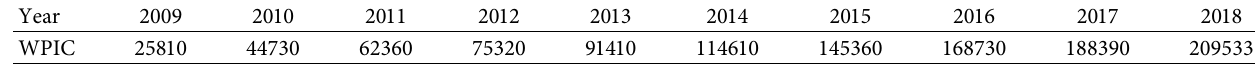
Table 1: China’s WPIC from 2009 to 2018 (ten thousand of kW).